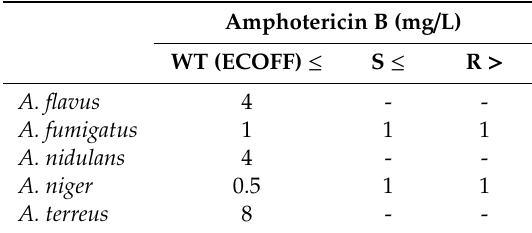
Table 1. ECOFFs and clinical breakpoints for amphotericin B against Aspergillus spp. according to the